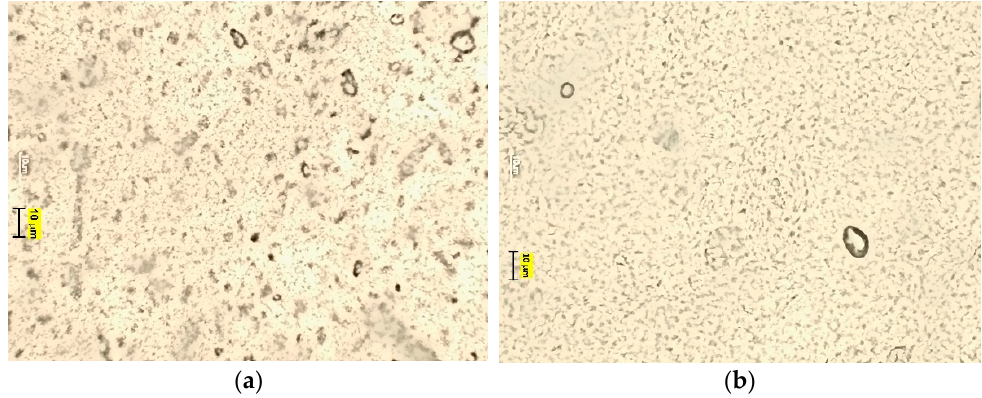
Figure 7. Microscopic image of cream with silicone-MPA, sample E3, magnification ( a ) 10×, ( b ) 40×.